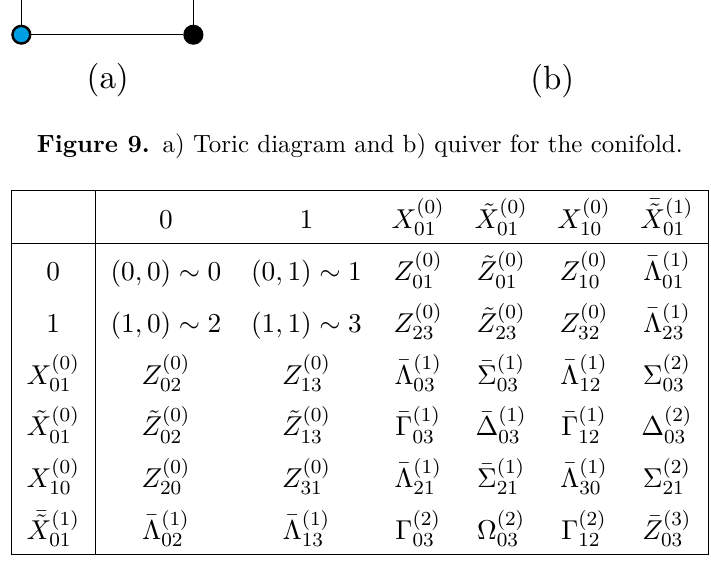
Table 2. Summary of how the nodes and fields in the conifold × conifold theory descend from the two parents. For simplicity, we converted the pairs of indices labeling nodes in the product to single indices. We also indicate the degree of the fields as a superindex. We use Latin and Greek letters to indicate chiral and Fermi fields,